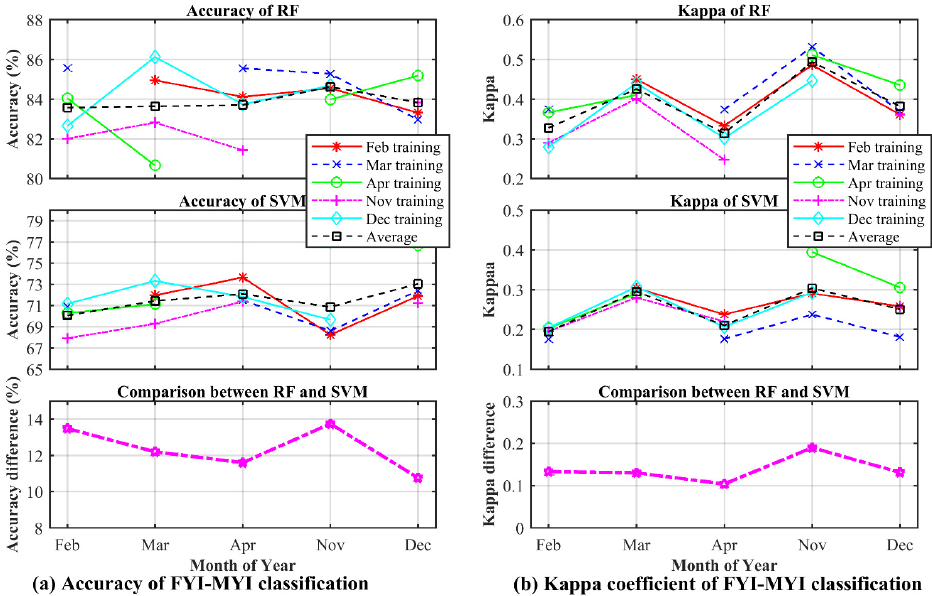
Figure 15. The ( a ) accuracy and ( b ) kappa coefficient of FYI-MYI classification using data of each month as the training set in turn. The top and middle plots in ( a ) represent the accuracy of RF and SVM respectively, while the lowest plot is the accuracy of RF minus that of SVM. The top and middle plots in ( b ) represent the kappa coefficient of RF and SVM respectively, while the lowest plot is the kappa coefficient of RF minus that of SVM.